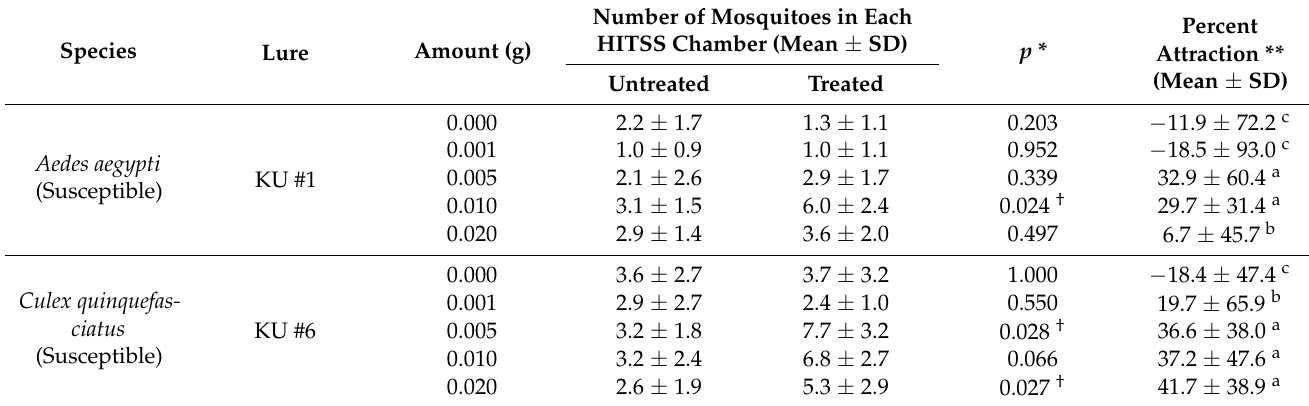
Table 2. Number of Aedes aegypti and Culex quinquefasciatus mosquitoes attracted to different amounts of each lure to determine the discriminating dose.